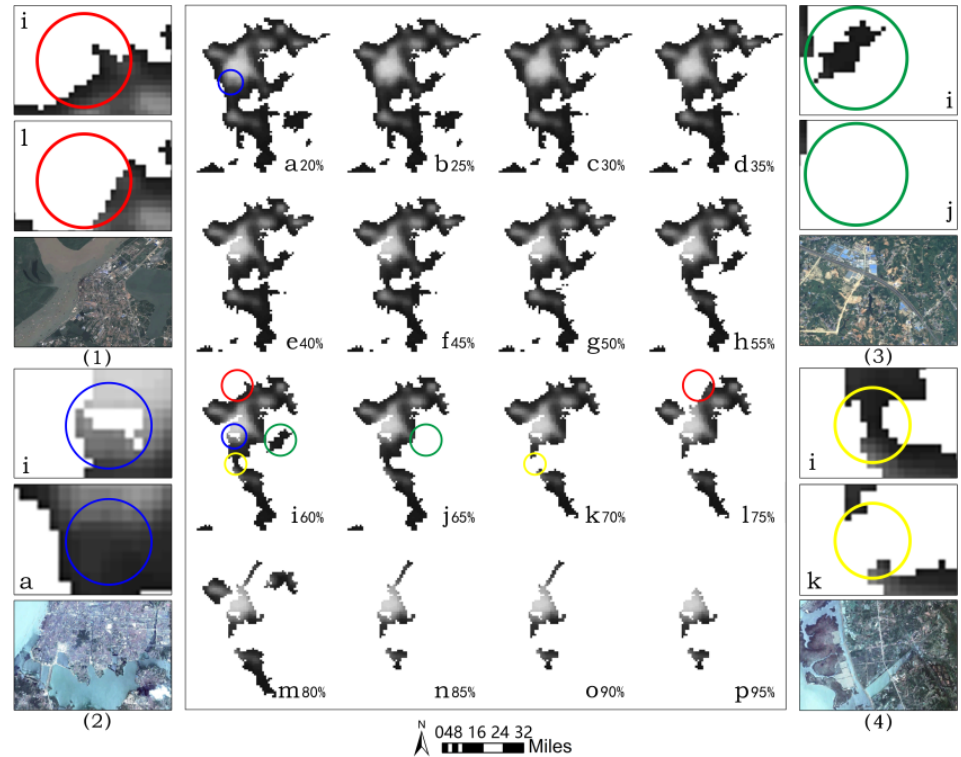
Figure 4. 2012 comparison of optimal threshold percentage segmentation parameter